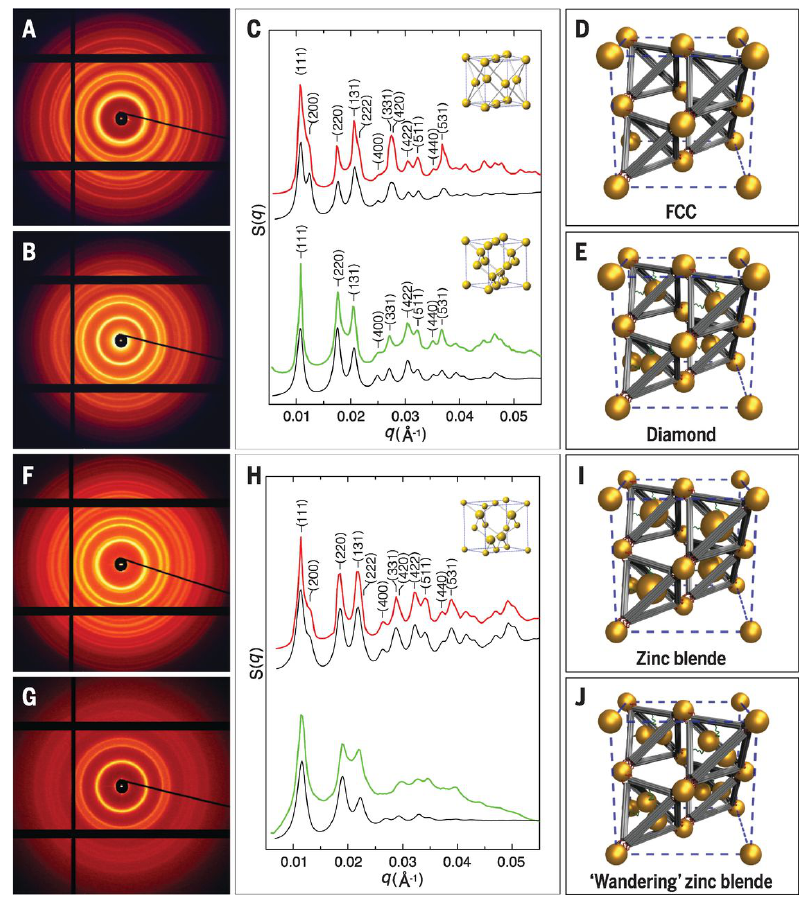
Figure 9. Structure of assemblies in a system shown in Figure 8. 2 D SAXS pattern of the assembled structures formed by basis particles of core diameter 14.5 nm and, ( A ) tetrahedral origami cages, ( B ) trivalent cages. Upper and lower part of ( C ) shows the experimental (red and green, respectively), and calculated (black) SAXS 1 D pattern corresponding to ( A , B ), respectively. ( D , E ) show the corre- sponding unit cell models. ( F , G ), again, show the 2 D SAXS pattern formed by basis particles of core diameter 8.7 nm and ( F ) with tetravalent caged particles of diameter 8.7 nm and, ( G ) with guest pairs of diameter 8.7 nm, caged inside a tetrahedra. ( H ) corresponds to ( C ), and ( I , J ) show unit cell models for ( F , G ), respectively. Reprinted from [80], with permission from